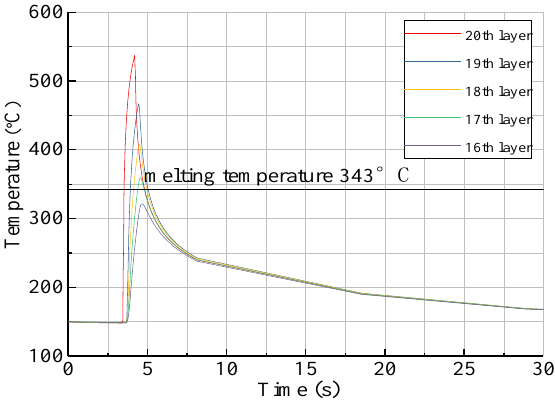
Figure 8. Temperature profiles of each layer at v = 20 mm/s and T = 700 °C.